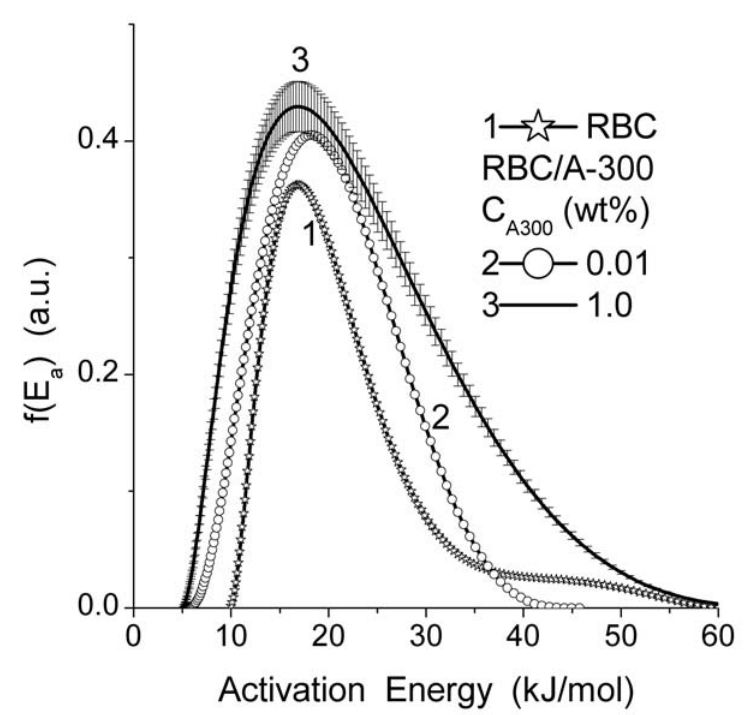
Fig. 7 Distribution function of activation energy of depolarisation for the RBCs in the trisodium citrate buffer and in the A-300 suspension (in TSC) at C A − 300 = 0 . 01 and 1.0 wt.% (error bar is shown) calculated with Eq.